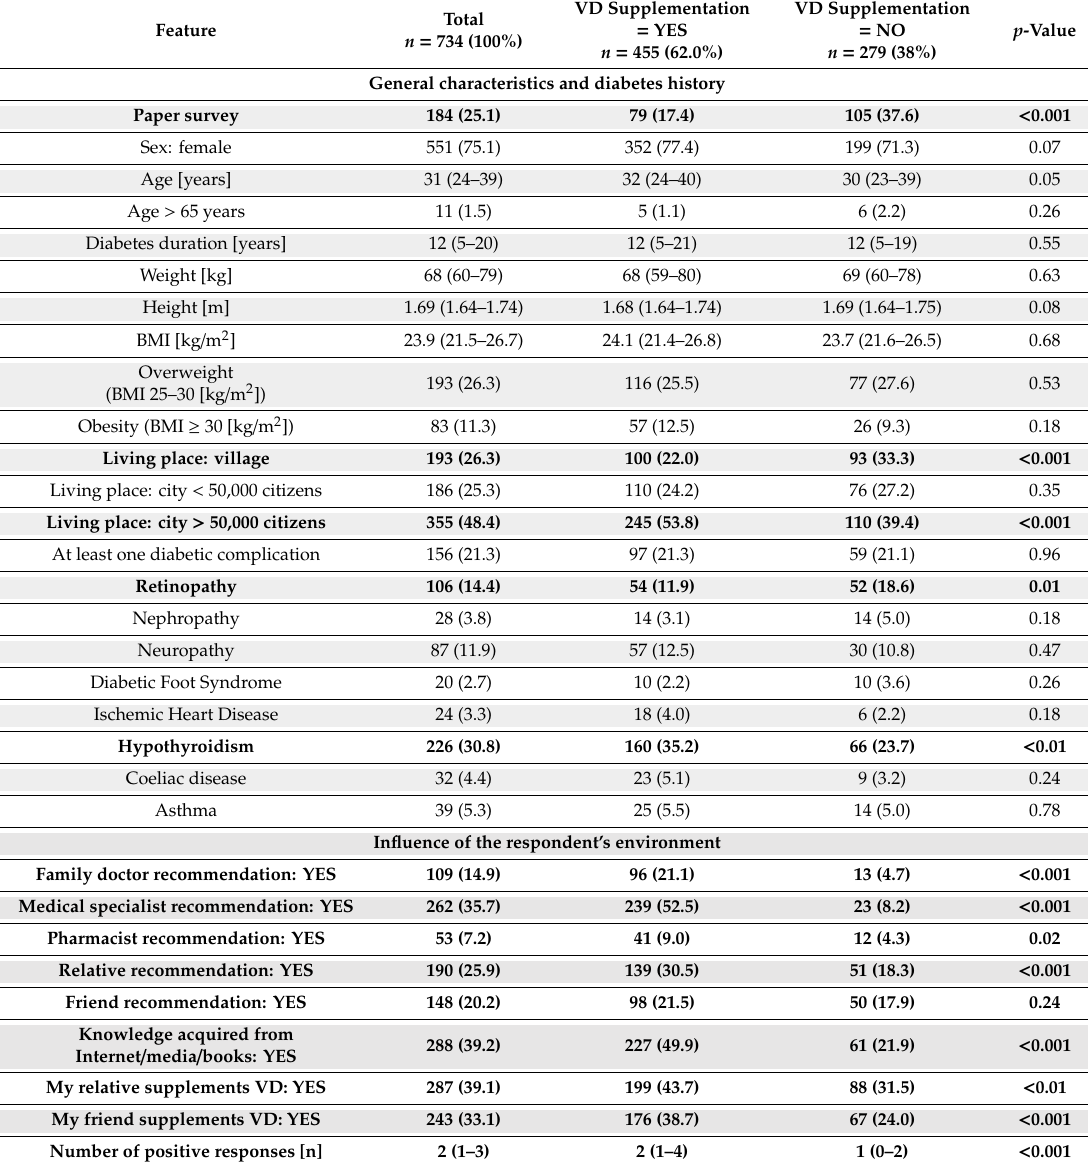
Table 1. Comparison between respondents who declared or denied vitamin D supplementation. Data presented as median (interquartile range) or number